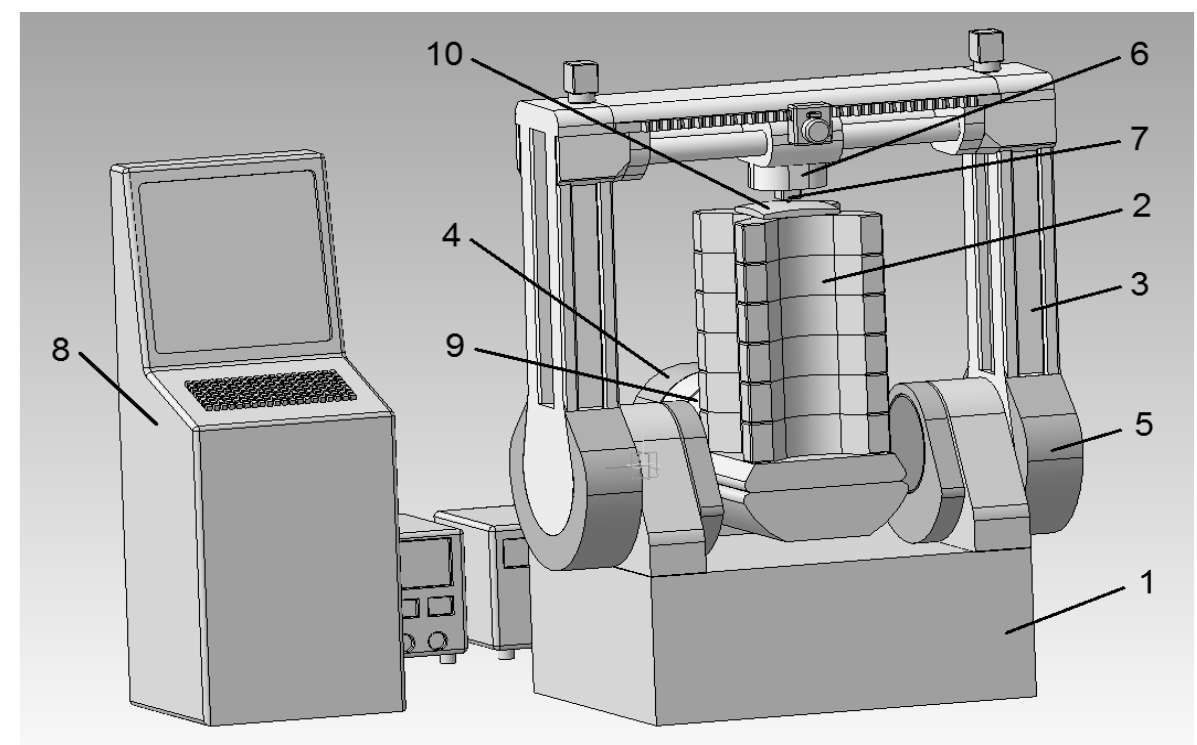
Fig. 1. The main units and elements of a pendulum-type ruling engine: 1 – base; 2 – blank carriage; 3 – diamond carriage; 4 – blank carriage drive; 5 – diamond carriage drive; 6 – diamond cutter hoisting and lowering mechanism; 7 – diamond cutter; 8 – blank carriage drive, diamond carriage drive, and diamond cutter hoisting/lowering mechanism control unit; 9 – angular position sensor of the blank carriage; 10 – substrate of the ruled diffraction grating that is being manufactured